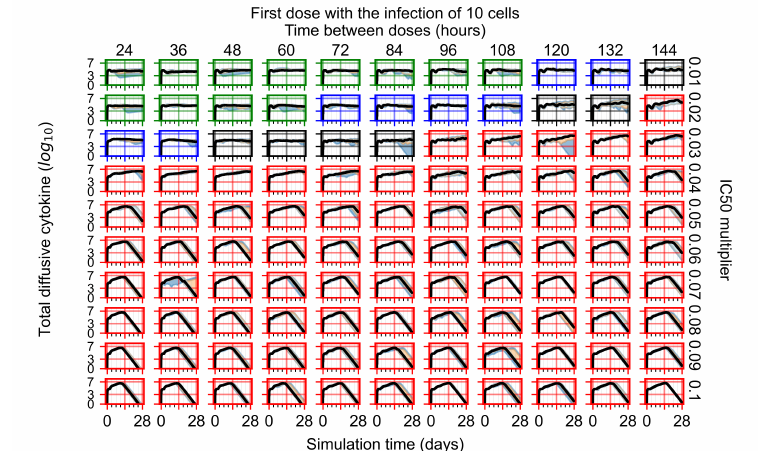
Figure A45. Diffusive cytokine amount, Y axis in log scale, and exponent values as tick marks.